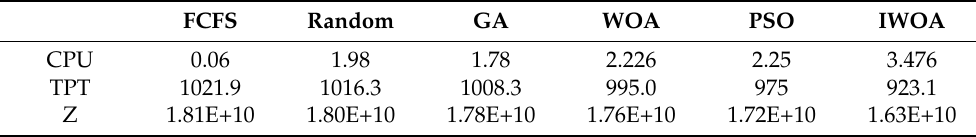
Table 4. The summary of different approaches.